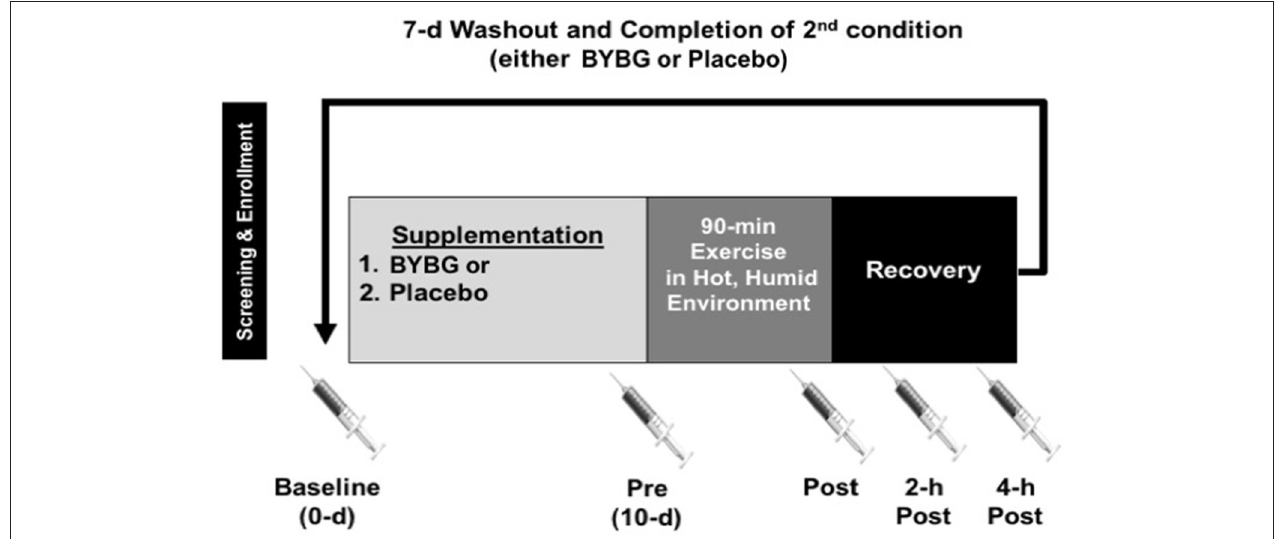
FIGURE 1 | Experimental timeline. After screening, subjects were randomized to an order to complete either a 10-days supplementation with BYBG (250 mg/d) or placebo (rice flour 250 mg/d). After 10-days of supplementation, subjects reported to the laboratory to complete an experimental exercise session (90-min) in a hot, humid environmental chamber. Venous blood samples were collected prior to supplementation (baseline), prior to exercise (Pre), within 5-min of the end of exercise (Post), 2- and 4-h post-exercise. The later three samples were used to assess the effect of exercise on early phase immunity. After collection of the 4-h sample, subjects completed a 7-days washout and repeated the entire protocol